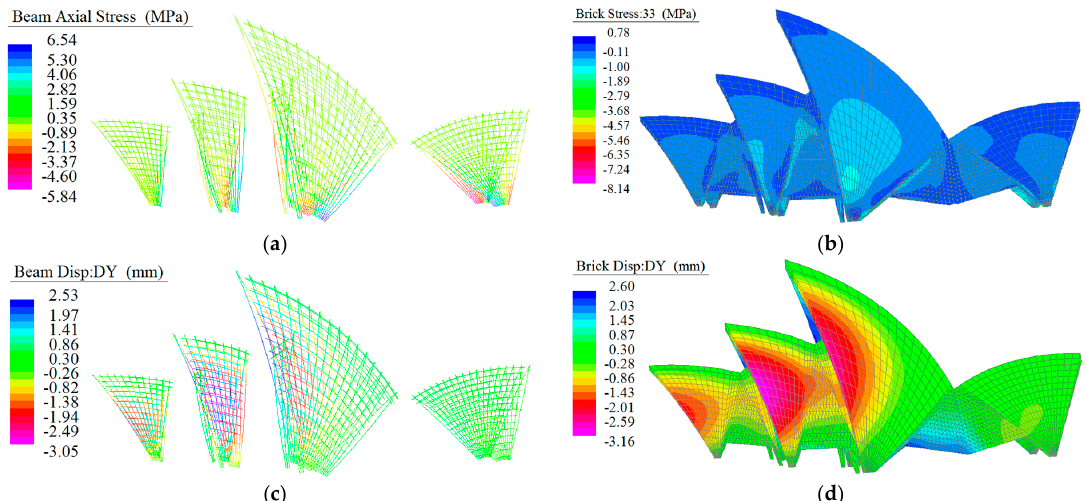
Figure 3. Strand7 five-year wind outputs (unscaled). ( a ) Cable stress, ( b ) concrete stress, ( c ) cable displacement, ( d ) concrete displacement.